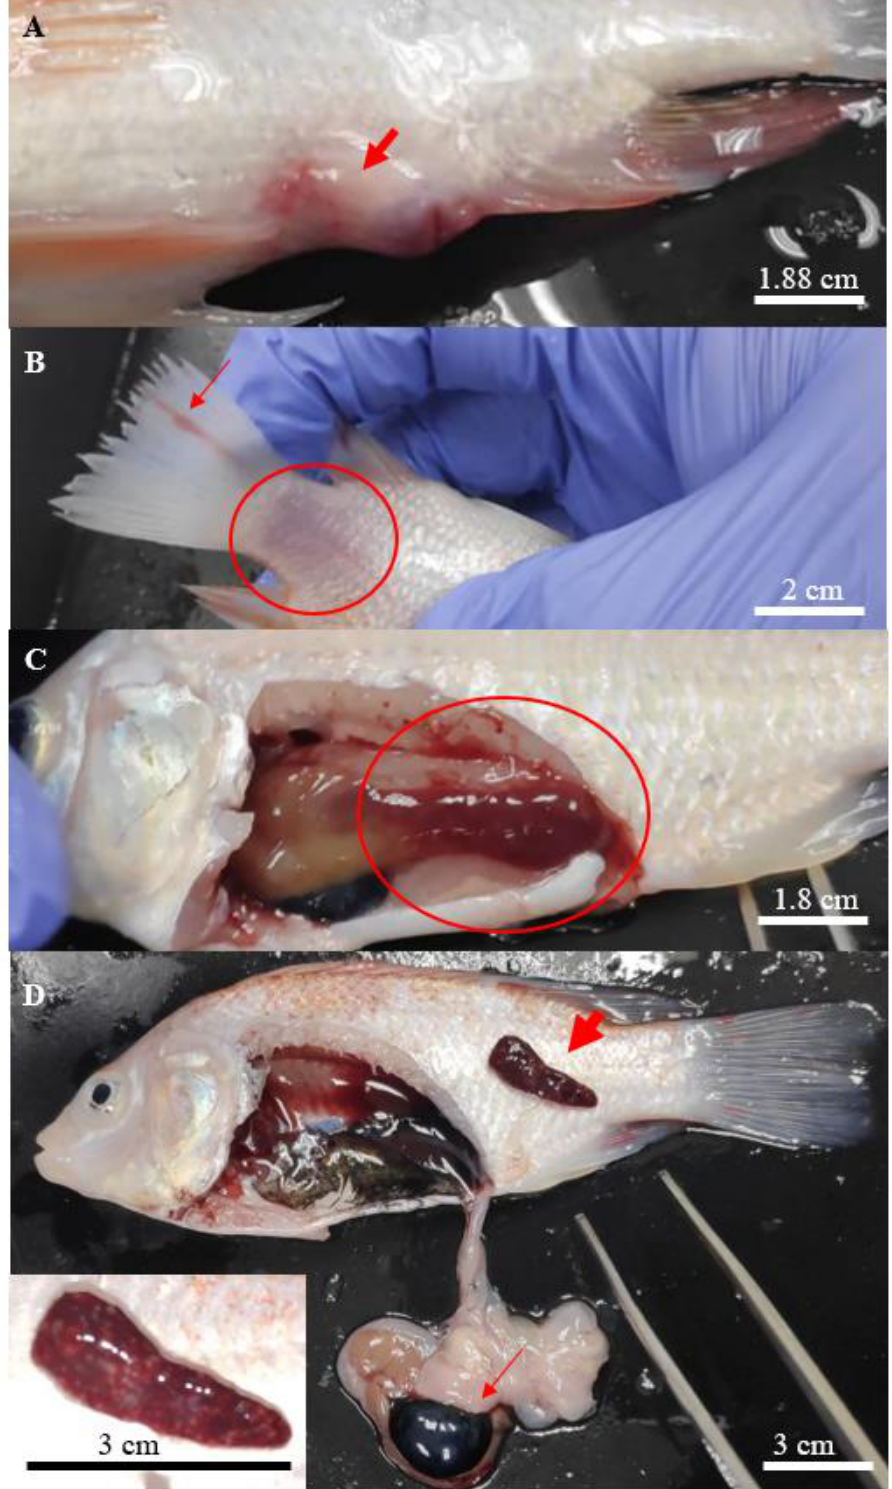
Figure 1. Clinical signs found on the hybrid red tilapias infected with Aeromonas . ( A ) focal haemor- rhage on the site of injection, ( B ) scale loss (circle) at the caudal peduncle with rotting caudal fin (thin arrow), ( C ) liver with deep haemorrhage (circle), and ( D ) haemorrhage with multiple white spots observed on the enlarged spleen (thick arrow), enlarged gallbladder (thin arrow), with a close-up picture of the affected spleen at the bottom left.